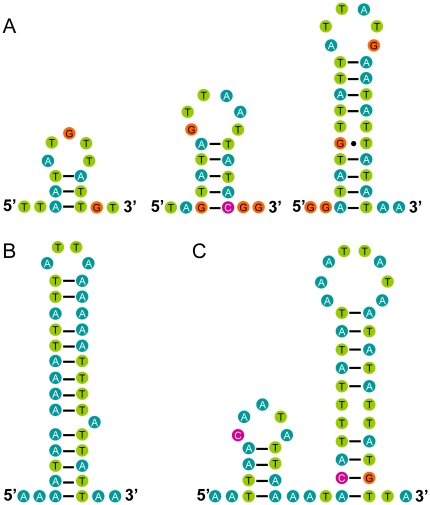
Secondary structures of non-coding regions of the mt genome of Stenopirates sp.Secondary structure of non-coding regions between (A) trnS2 and rrnL (CR); (B) cytB and trnS2; (C) trnT and nad6. Inferred Watson-Crick bonds are illustrated by lines, GU bonds by dots.